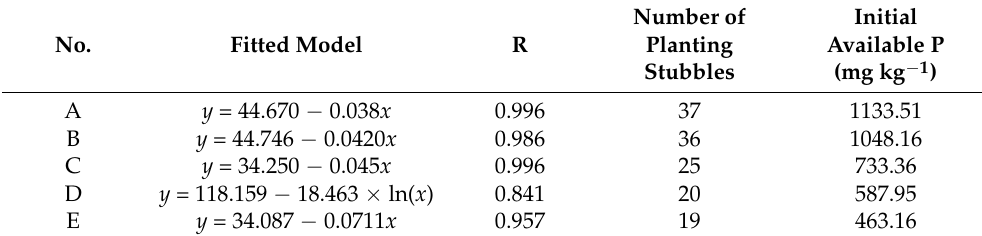
Table 6. Fitted model between planting stubbles and content of available phosphorus in a protected field and the number of planting stubbles required for the phosphorus needs of spinach to be satisfied. No. Fitted Model R